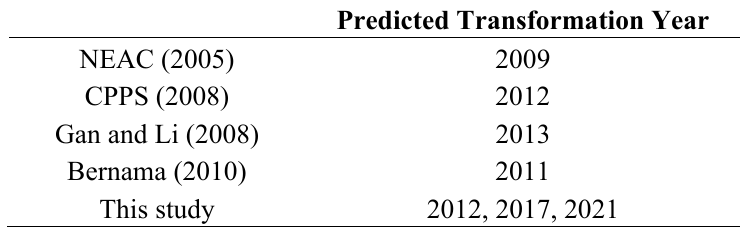
Table 5. Predictions of Malaysia becoming oil net-importer